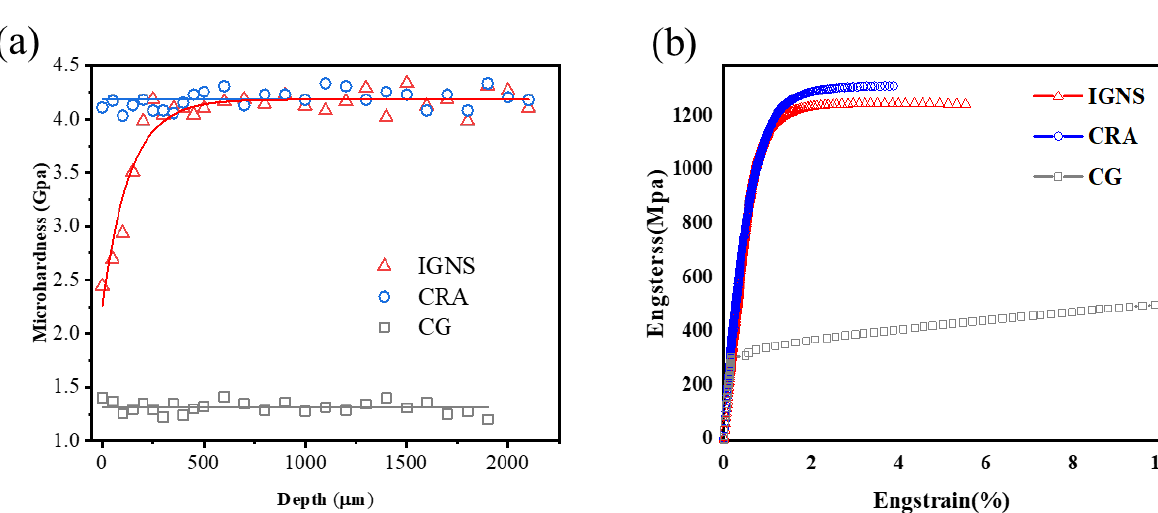
Figure 5. ( a ) Cross-sectional hardness profiles and ( b ) uniaxial tensile curves of samples in various conditions. Corresponding uniaxial tensile tests are displayed in Figure 5b. The CG sample yielded at 305 MPa and obtained a uniform elongation of 40%. For the IGNS and CRA